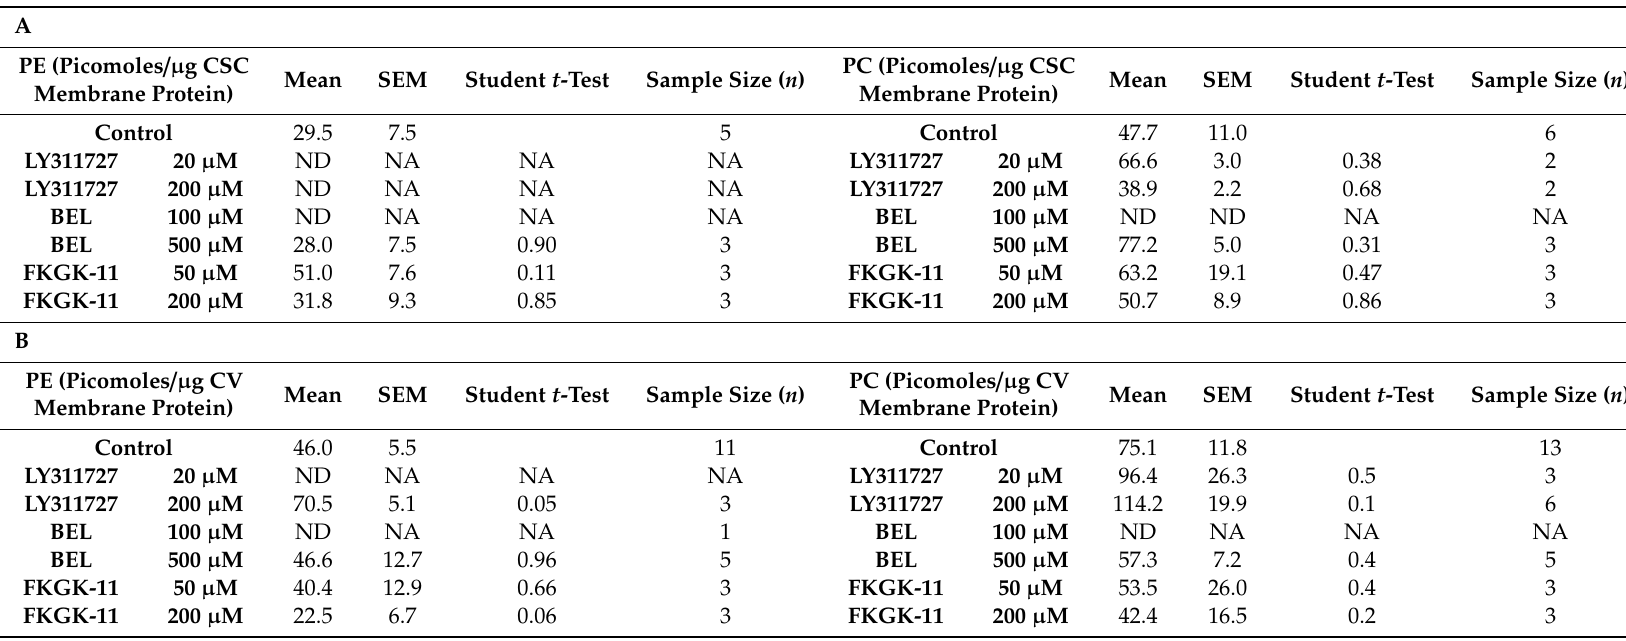
Table 2. Endogenous PE and PC levels in ( A ) CSC and ( B ) CV, treated with the indicated doses of the inhibitors. ND-not done; NA-not applicable. A PE (Picomoles / µ g CSC